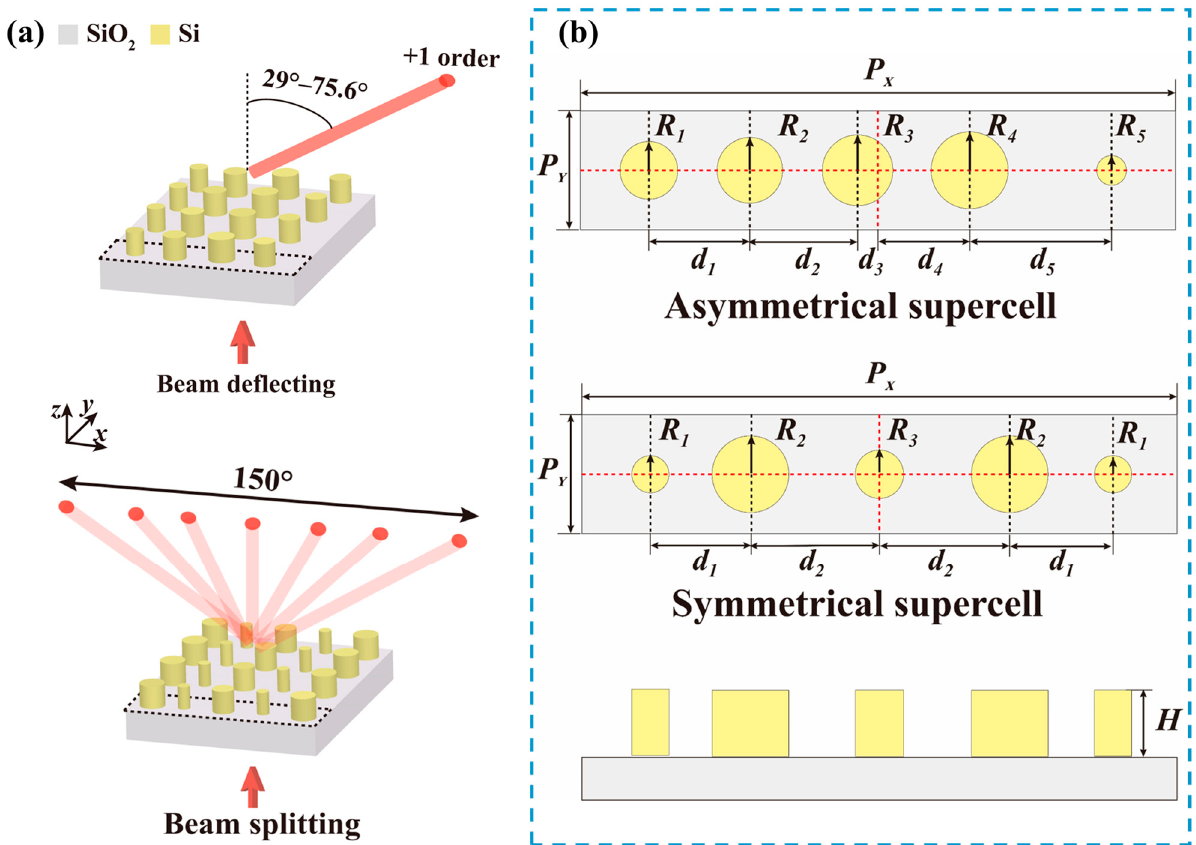
Figure 1. ( a ) Schematics of quasi ‐ freeform metasurfaces for wide ‐ angle beam deflecting (upper panel) and splitting (lower panel); ( b ) schematics of the supercells in quasi ‐ freeform metasurfaces. The upper and middle panels corresponded to the top views of the asymmetrical and symmetrical supercell, and the lower panel illustrates the side view of the supercell.